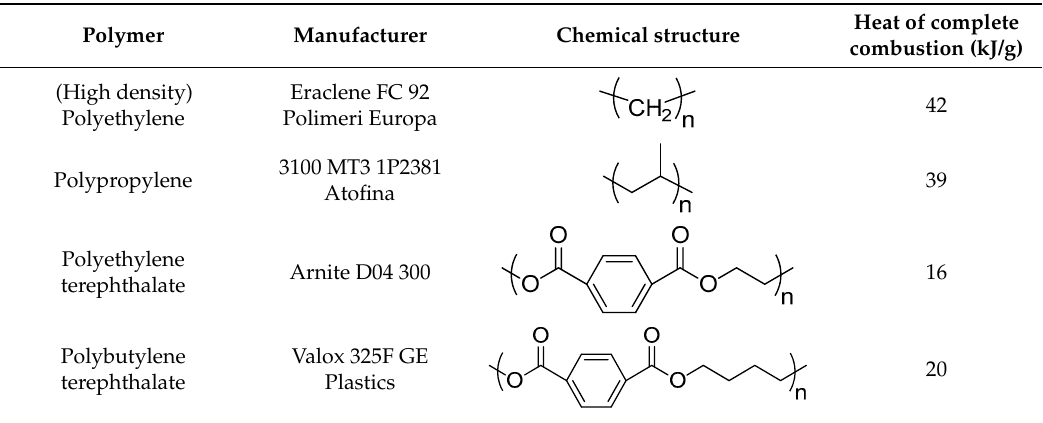
Table 1. Polymers studied in this work.